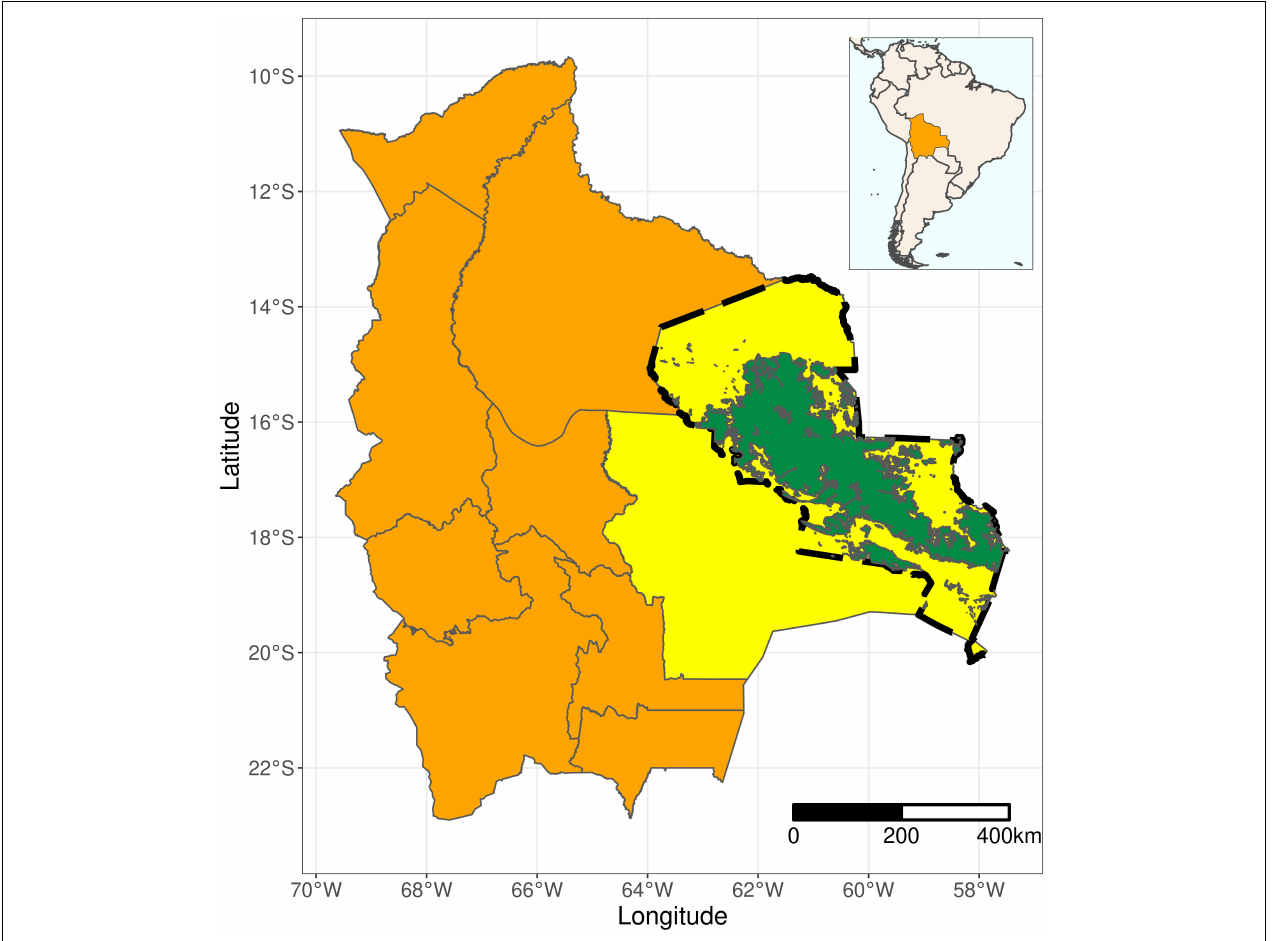
FIGURE 1 | Location of the study area. Bolivia, in orange, is shown with its departmental subdivision, with the department of Santa Cruz highlighted in yellow. The expanse of the Chiquitanía ecoregion (as defined on GeoBolivia) is shown using a dashed line, with the Subhumid Semi-deciduous Vegetation type (Navarro, 2011), which is the focus of this study, shown in green. The inset (top right) highlights the position of Bolivia on the South American